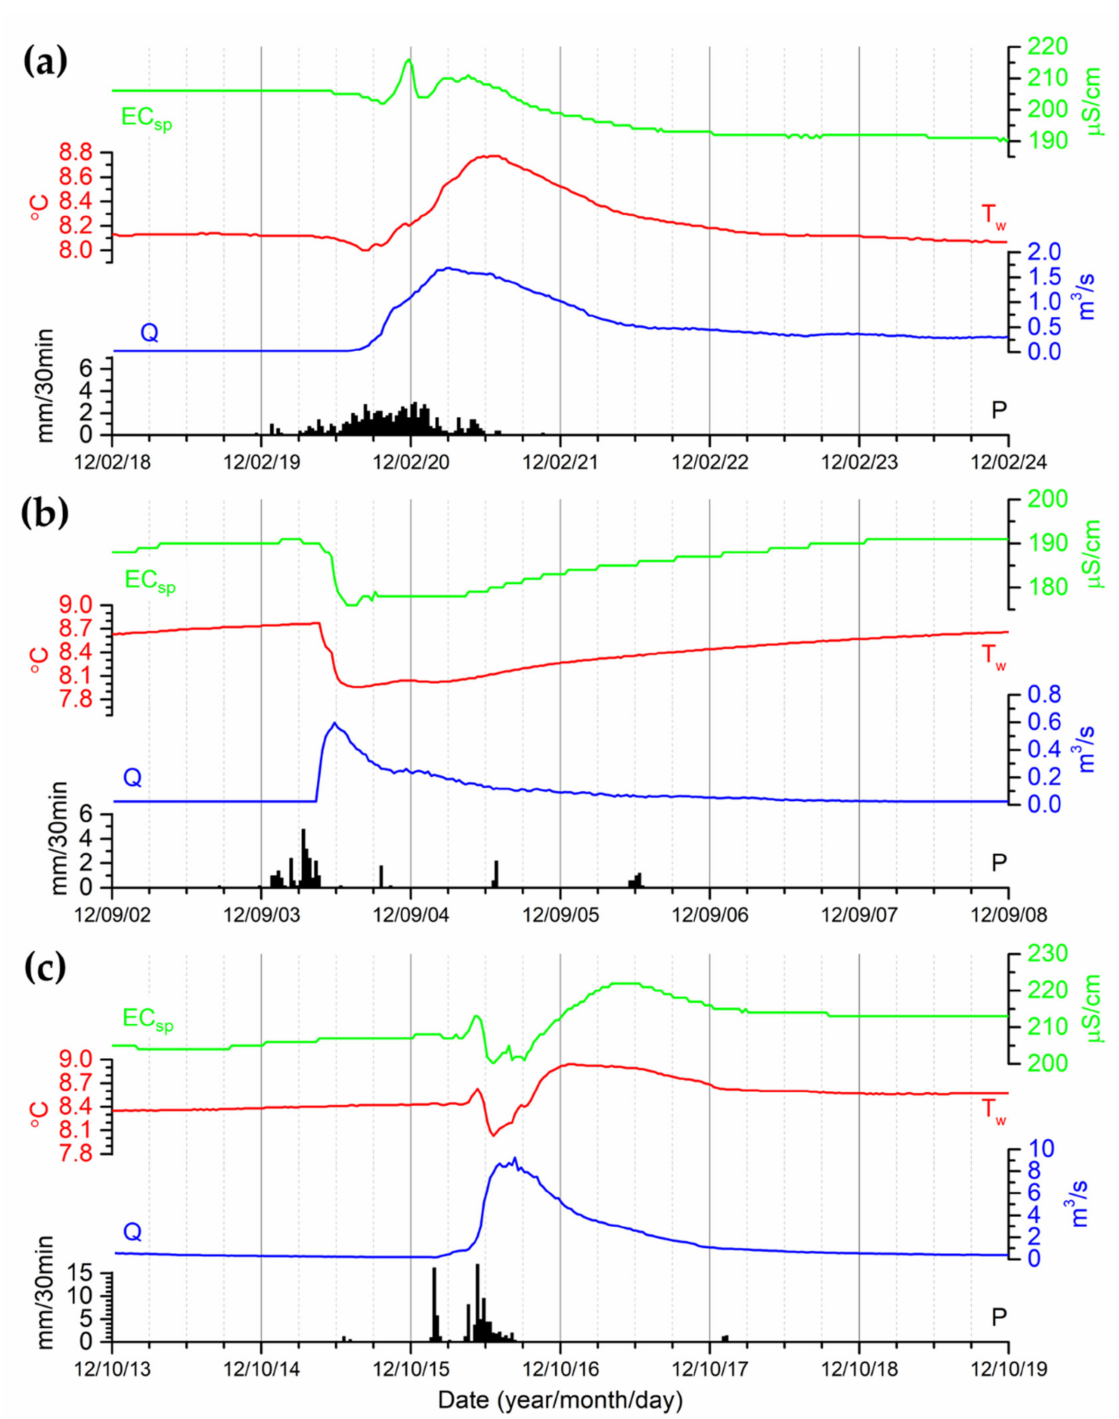
Figure 8. Examples of storm HTC-graphs observed at the Pollaccia spring. Each one highlights some features of the spring hydrodynamic response to precipitation: ( a ) low-magnitude winter storm event (event n. 6, see also Figure 4, Table 4 and SM); ( b ) small-scale discharge peak at the end of the summer drought (n. 18); ( c ) high-magnitude autumnal storm event (n. 23). The second HTC-graph (Figure 8b) shows a weak discharge peak (Q c = 0.6 m 3 /s) that occurred at the end of the summer drought phase. The rainfall event that triggered the discharge increase was more concentrated than in the previous example, and it showed a P rate of 3 mm/h for a precipitation interval of 7.5 h. The thermograph and